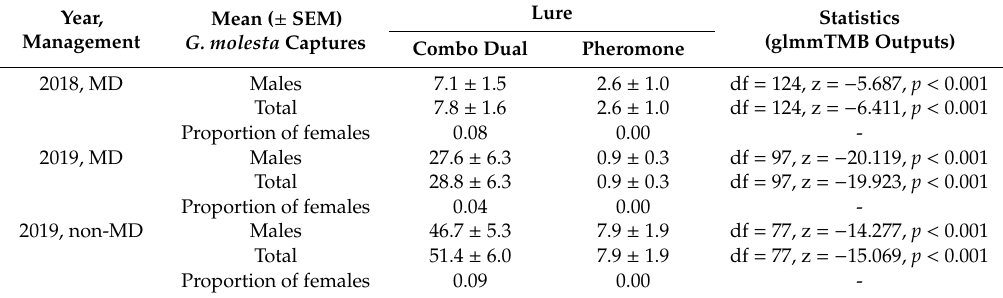
Table 3. Mean ( ± SEM) of total Grapholita molesta captures over the trial period (6-8 weeks) in traps baited with Tr é c é Inc. lures Pherocon ® OFM Combo Dual (Combo Dual) and Pherocon ® OFM L 2 (Pheromone). Pherocon ® OFM Combo Dual consisted in a grey halobutyl rubber septum loaded with the three-component sex pheromone blend for G. molesta and the sex pheromone of Cydia pomonella and a second membrane cup loaded with a blend of terpinyl acetate and acetic acid. Thirty-three trials were performed in 2018-2019 in peach and nectarine orchards treated or not treated with mating disruption